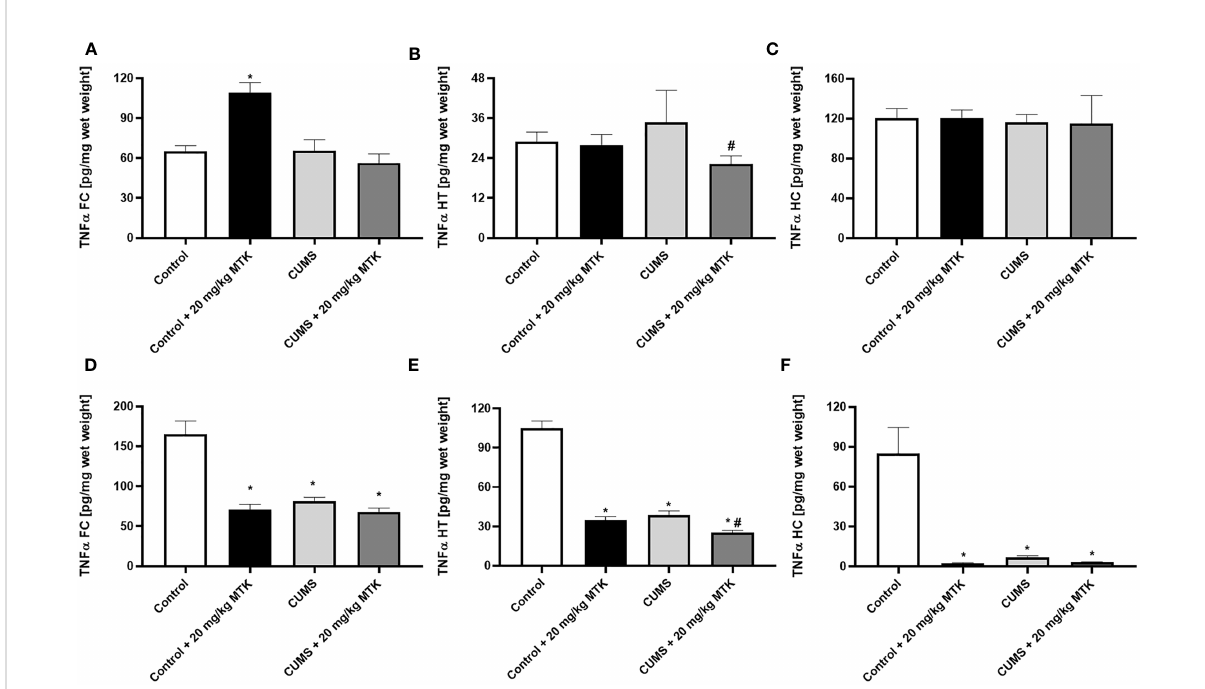
FIGURE 9 Effects of MTK on brain TNF- a levels. Male (A-C) and female (D-F) rats were exposed to CUMS or control conditions for four weeks and then, while remaining under these conditions, were treated for two weeks with MTK 20 mg/kg or vehicle. TNF- a levels in FC (A, D) , HT (B, E) and HC (C, F) were determined by ELISA. Each column is the mean ± SEM of 12 to 18 rats per group. Using one-way ANOVA (with Benjamini – Hochberg False Discovery Rate), followed by Student ’ s t-test for speci fi c group comparisons: *p < 0.05 vs. Control + DMSO; #p < 0.05 vs. CUMS +